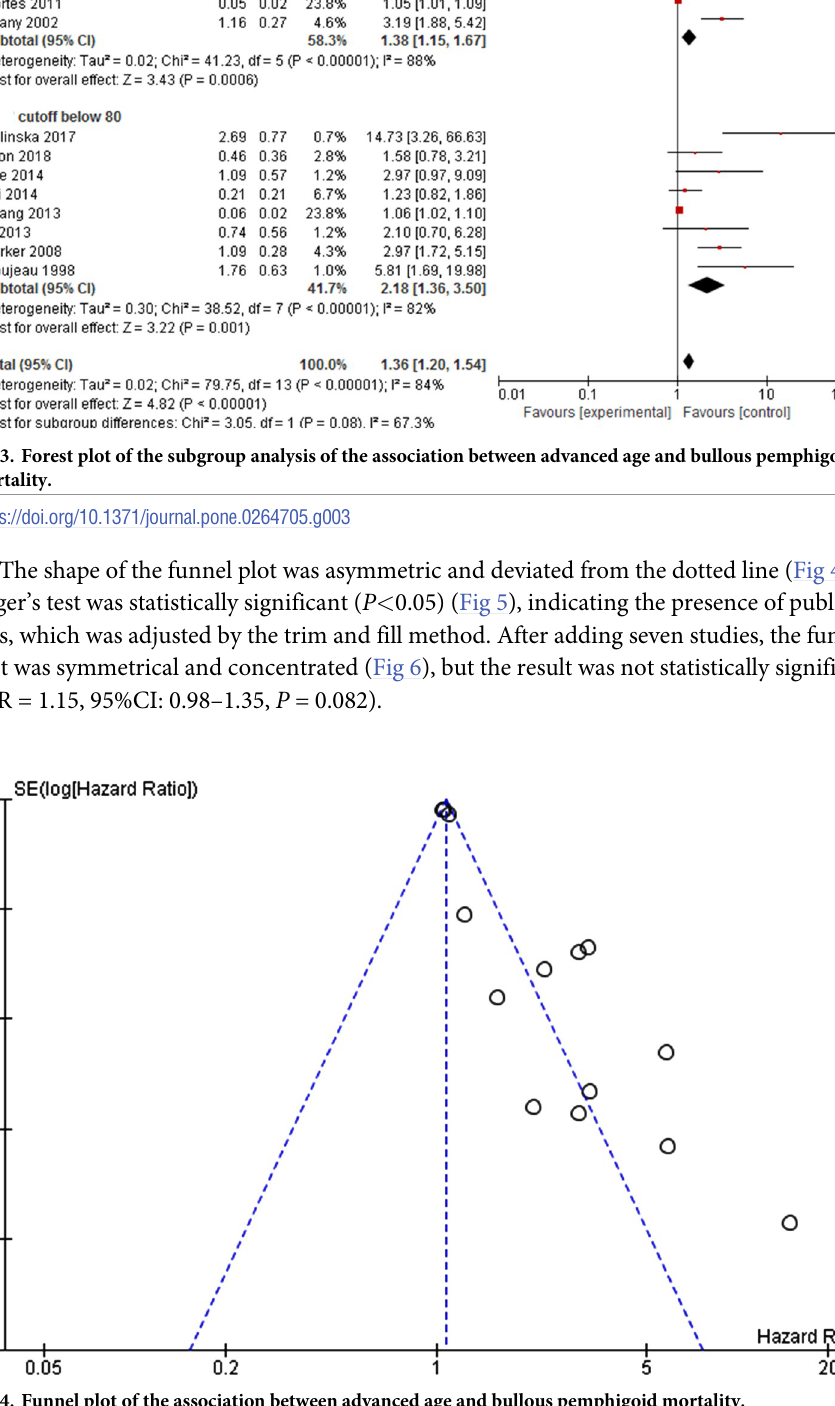
Fig 4. Funnel plot of the association between advanced age and bullous pemphigoid